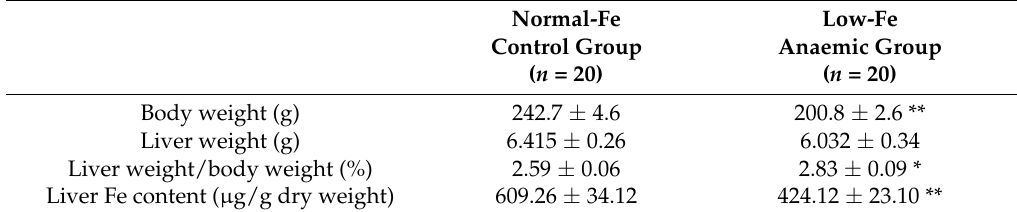
Table 3. Hepatosomatic index and liver Fe content in control and anemic